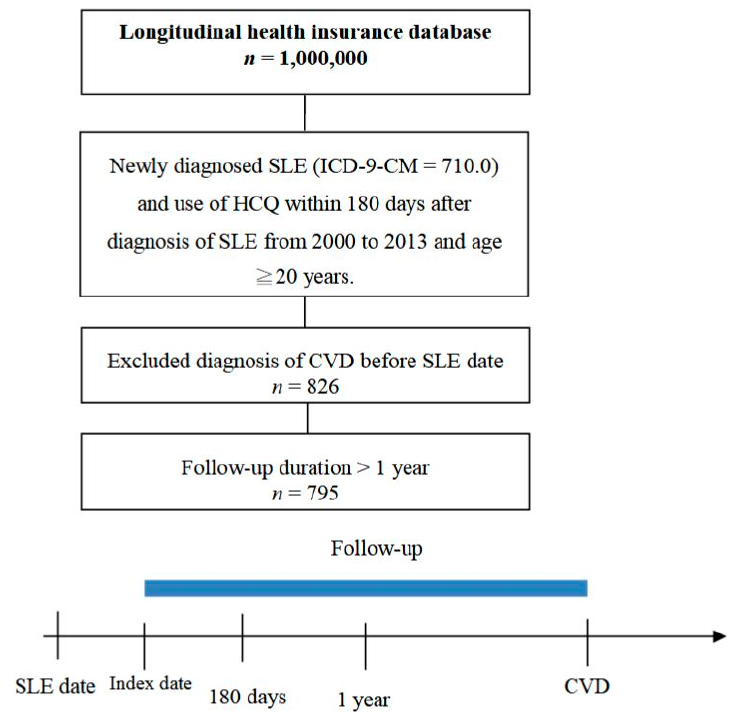
Figure 1. Study flow chart of the SLE patients with progression of CVD. SLE: Systemic lupus erythematosus; CVD: cardiovascular disease; HCQ: Hydroxychloroquine; ICD-9-CM: International Classification of Diseases-9-Clinical Modification.